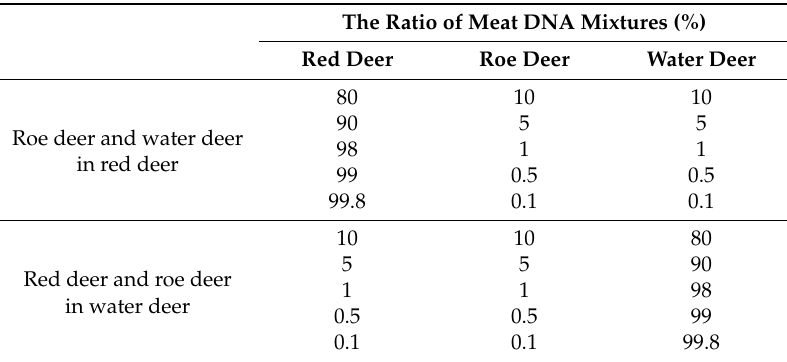
Table 2. The ratio of meat DNA mixtures used in this study. The Ratio of Meat DNA Mixtures